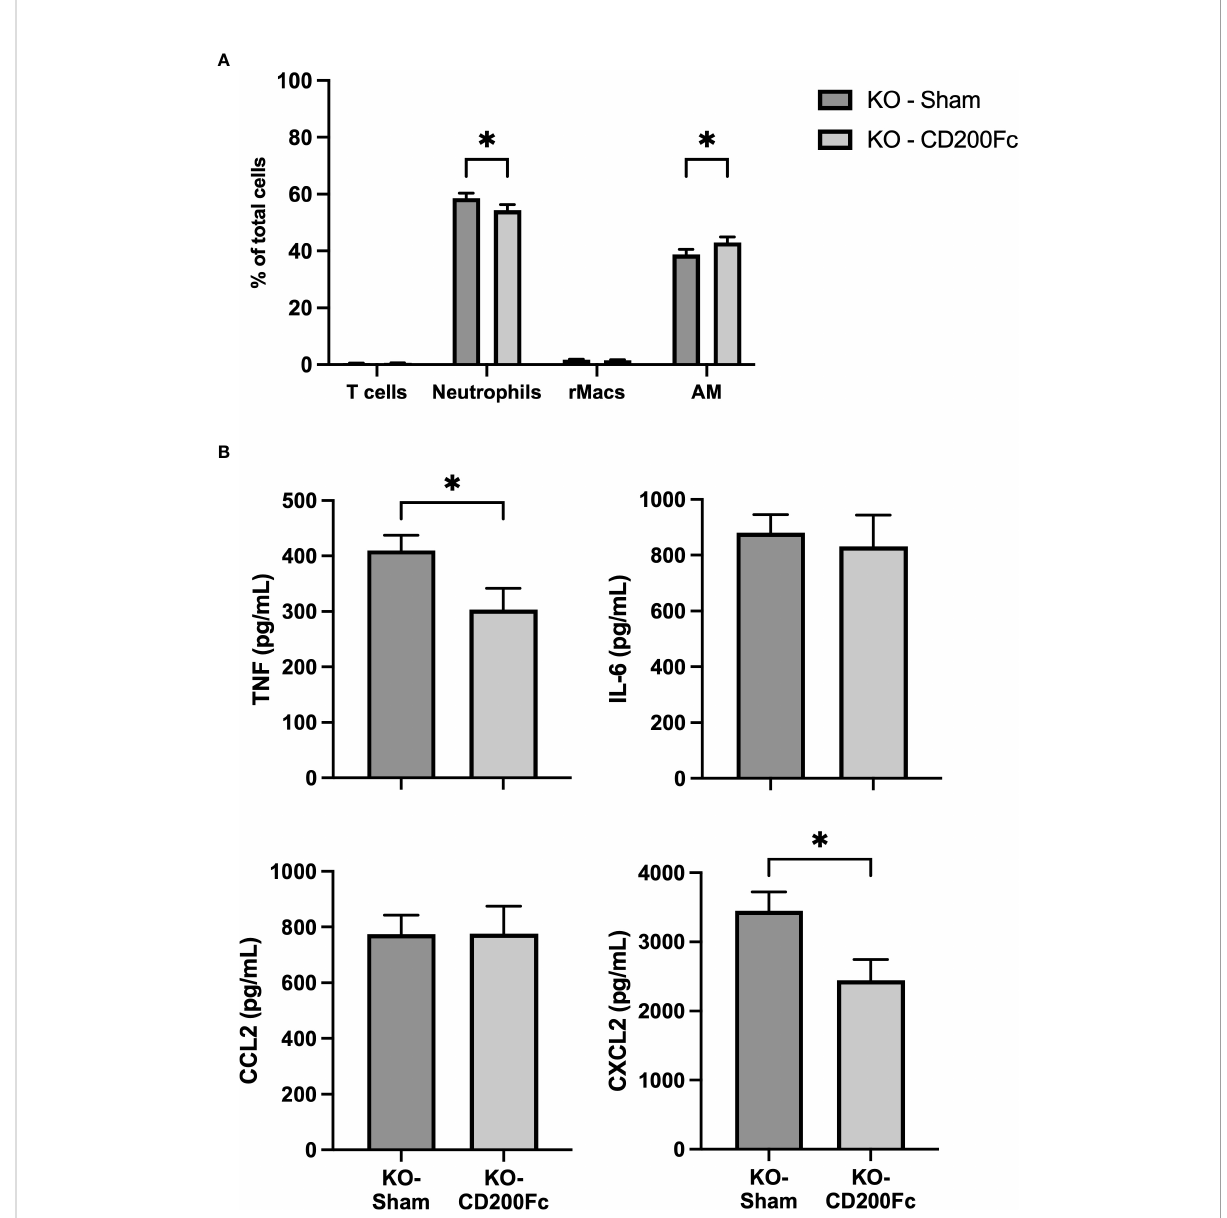
FIGURE 5 CD200Fc administration diminishes exacerbated acute in fl ammatory response in CD200 KO. CD200 KO rats were exposed to LPS intratracheally in combination with either recombinant IgG1 (sham) or CD200Fc, and BAL were performed 3h post-LPS. (A) BAL cell types were identi fi ed using fl ow cytometry, including T cells, Neutrophils, recruited in fl ammatory macrophages (rMacs), and alveolar macrophages (AMs). (B) In fl ammatory mediators were measured by ELISA. CD200Fc treatment reduced levels of TNF and CXCL2, without altering IL-6 and CCL2 levels. Data are from individual rats, with n = 6-8 per group of two independent experiments. Statistical signi fi cance was determined using two- way ANOVA followed by Bonferroni ’ s multiple comparisons or Mann-Whitney T-Test; *P <